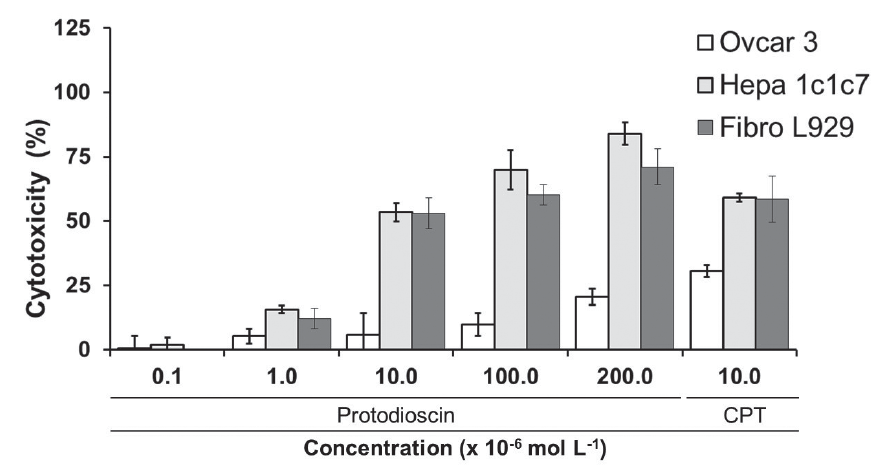
FIGURE 2 - Effect of protodiscin on cell viability. L929 fibroblasts, ovarium carcinoma (Ovcar 3) and hepatoma (Hepa 1c1c7) cells were treated with 0.1, 1.0, 10.0, 100.0 and 200.0 x 10 -6 mol L -1 of protodioscin for 24 h. Values represent the percentage of cell death ± SD of three independent experiments tested by the MTT